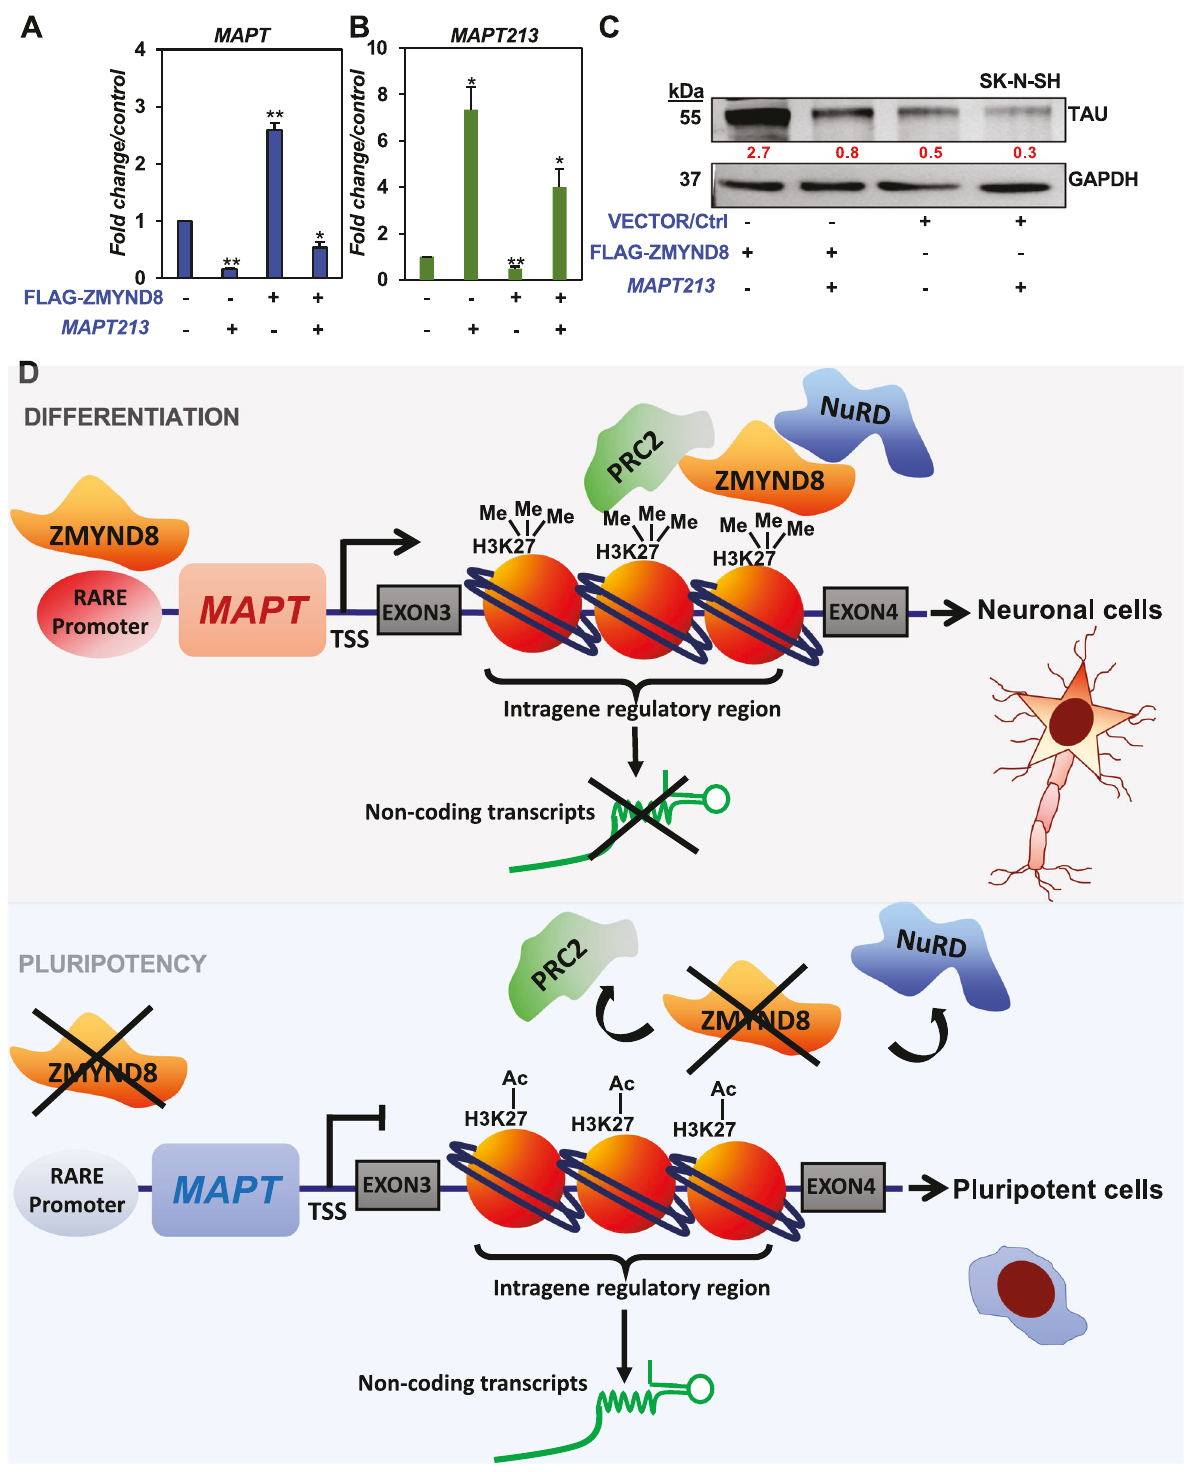
Fig. 8 Antagonistic relationship between MAPT213 and full-length MAPT transcription. A , B qRT-PCR showing expression of full-length MAPT ( MAPT ) ( A ) or MAPT213 ( Intra gene transcript ) ( B ) in either ZMYND8 alone, MAPT213 alone, or both ZMYND8 and MAPT213 overexpressed SK- N-SH cells. C Immunoblots showing expression of TAU in either ZMYND8 alone, MAPT213 alone, or both ZMYND8 and MAPT213 overexpressed SK-N-SH cells; GAPDH served as a loading control. The immunoblots are quanti fi ed and represented as numerical, re fl ecting the band intensity normalized to loading control. D Model depicting ZMYND8-dependent transcriptional regulation of MAPT . Error bars indicate sem.; n = 3; three independent experiments. A two-tailed t -test was used to calculate P -values. * P < 0.05; ** P < 0.01.